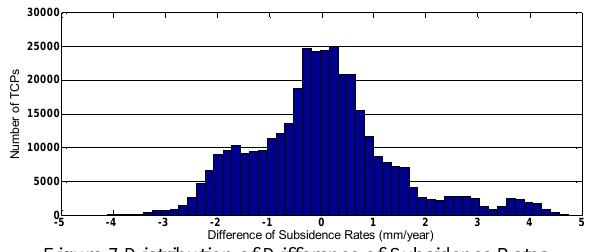
Figure 7.Distribution of Difference of Subsidence